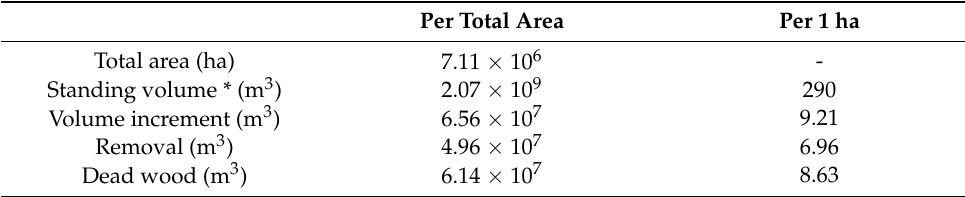
Table 2. Characteristics of forest resources in Polish State Forests in the years